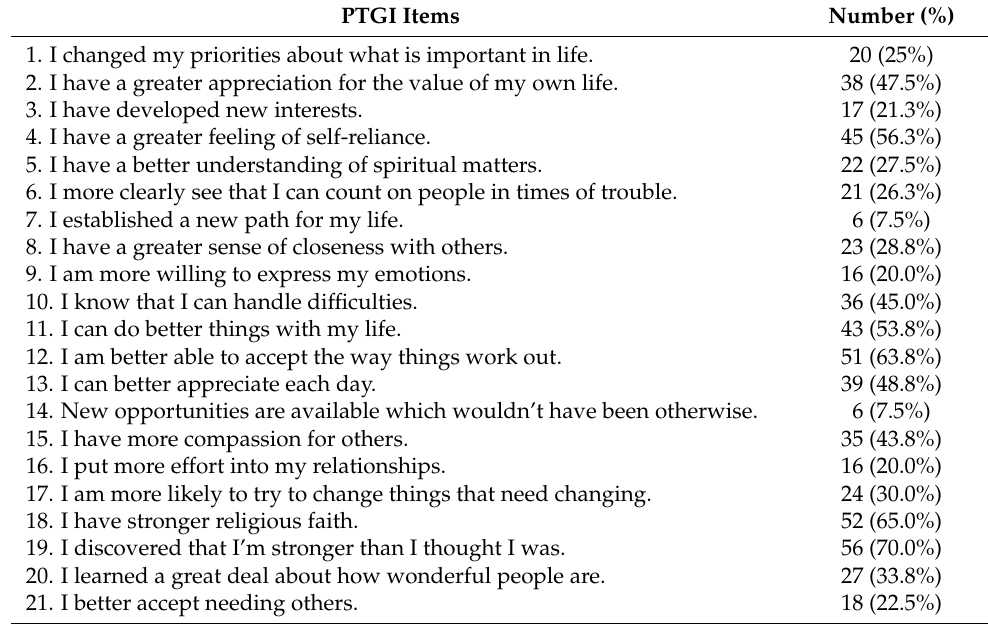
Table 3. Percentage of women who answered “I experienced this change as a result of my crisis to a small degree” to “to a very great degree” to each of the PTGI